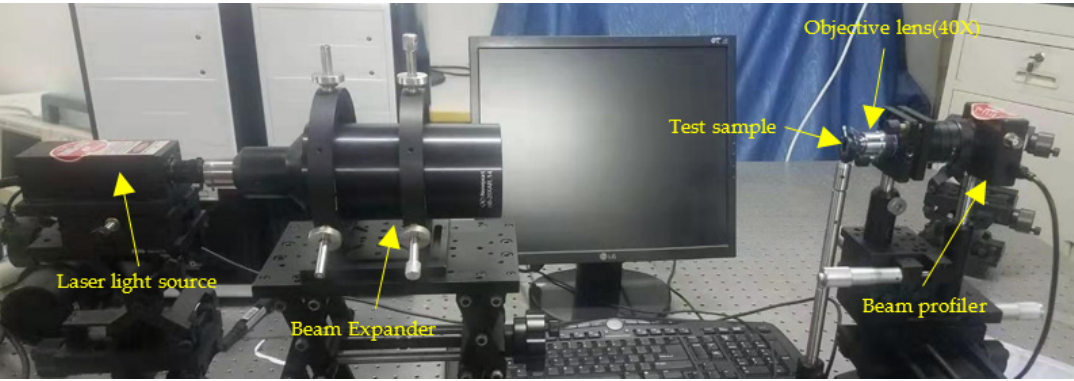
Figure 9. Measurement system for acquiring common optical characteristics of the CSPAs.